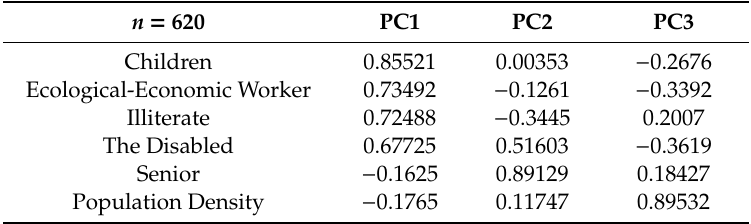
Figure 6. ( a , c ): Heat exposure index and Heat vulnerability index of Crichton’s risk triangle; ( b , d ): Sensitivity and Adaptability of heat vulnerability index (HVI). Table 1. Principal component (PC) coefficients (loadings) for the sensibility variables for the three retained varimax-rotated principal components.